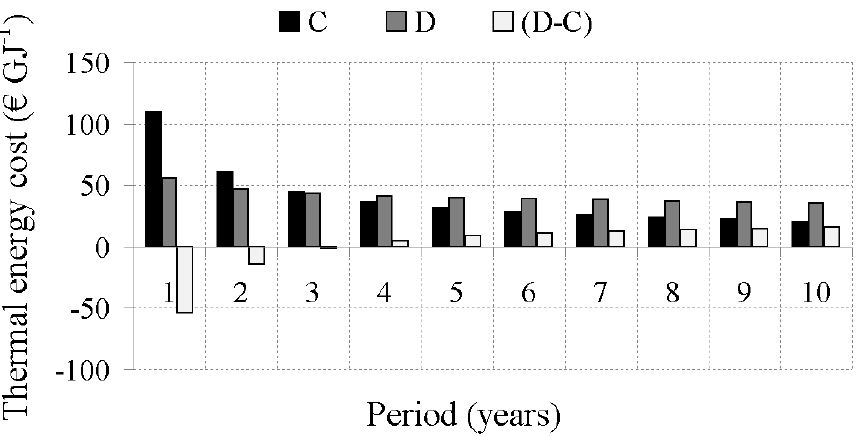
Figure 5. Variation of the thermal energy production cost (€·GJ − 1 ) of the wood chips system and the diesel system, during the considered period. The differences between the two systems (C = wood chips heating system; D = Diesel heating system) was reported (saving of C vs. D).